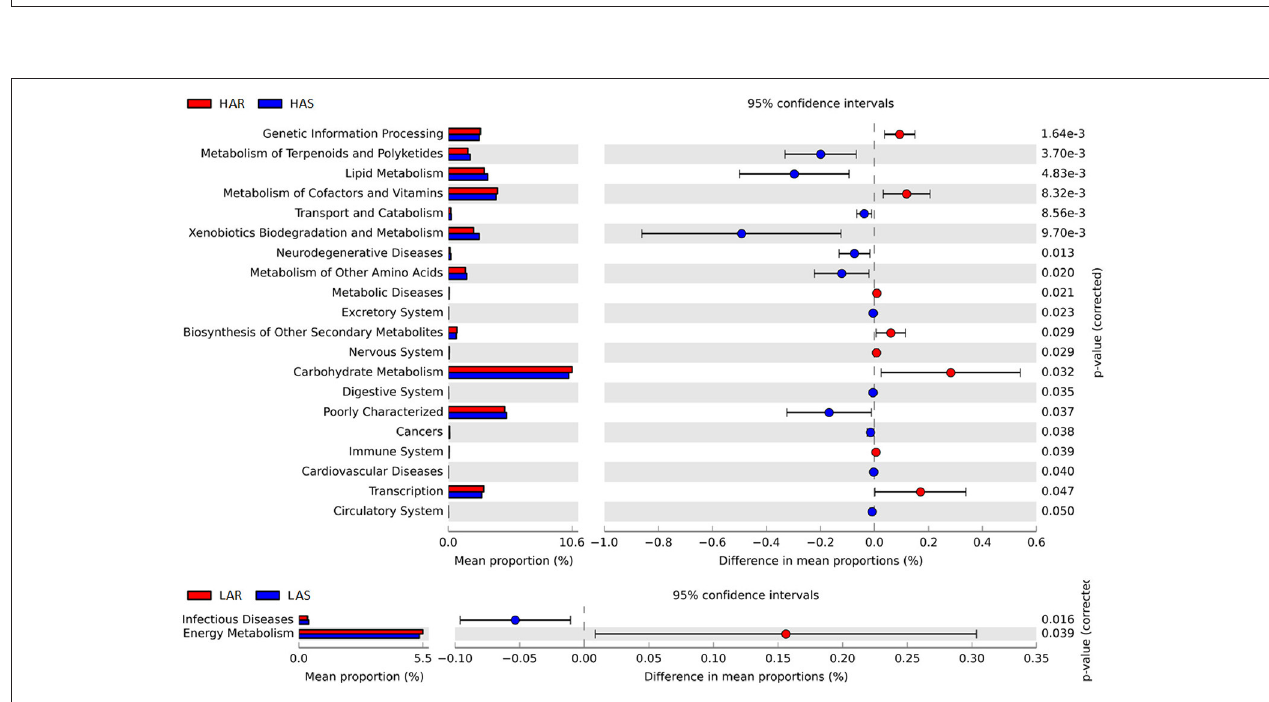
FIGURE 7 | Comparisons of functional pathways between microbes of HAS vs. HAR (Top) and LAS vs. LAR (Bottom) . The pathways shown in the figure were predicted by PICRUSt.